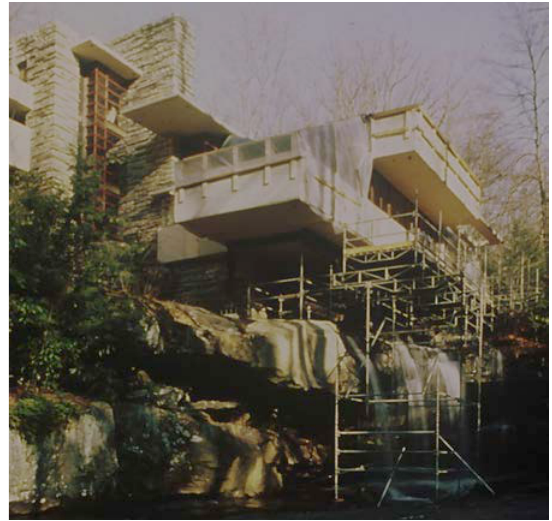
Figure 5. Fallingwater during Phase 3 of the restoration when the flagstones were lifted from the living room, its east and west terraces, and the master-bedroom terrace above (Wank Adams Slavin Associates, 2004) With funding from Save America’s Treasures and other sources, including the state of Pennsylvania, the $13.5 million restoration was completed by 2005 (Figure